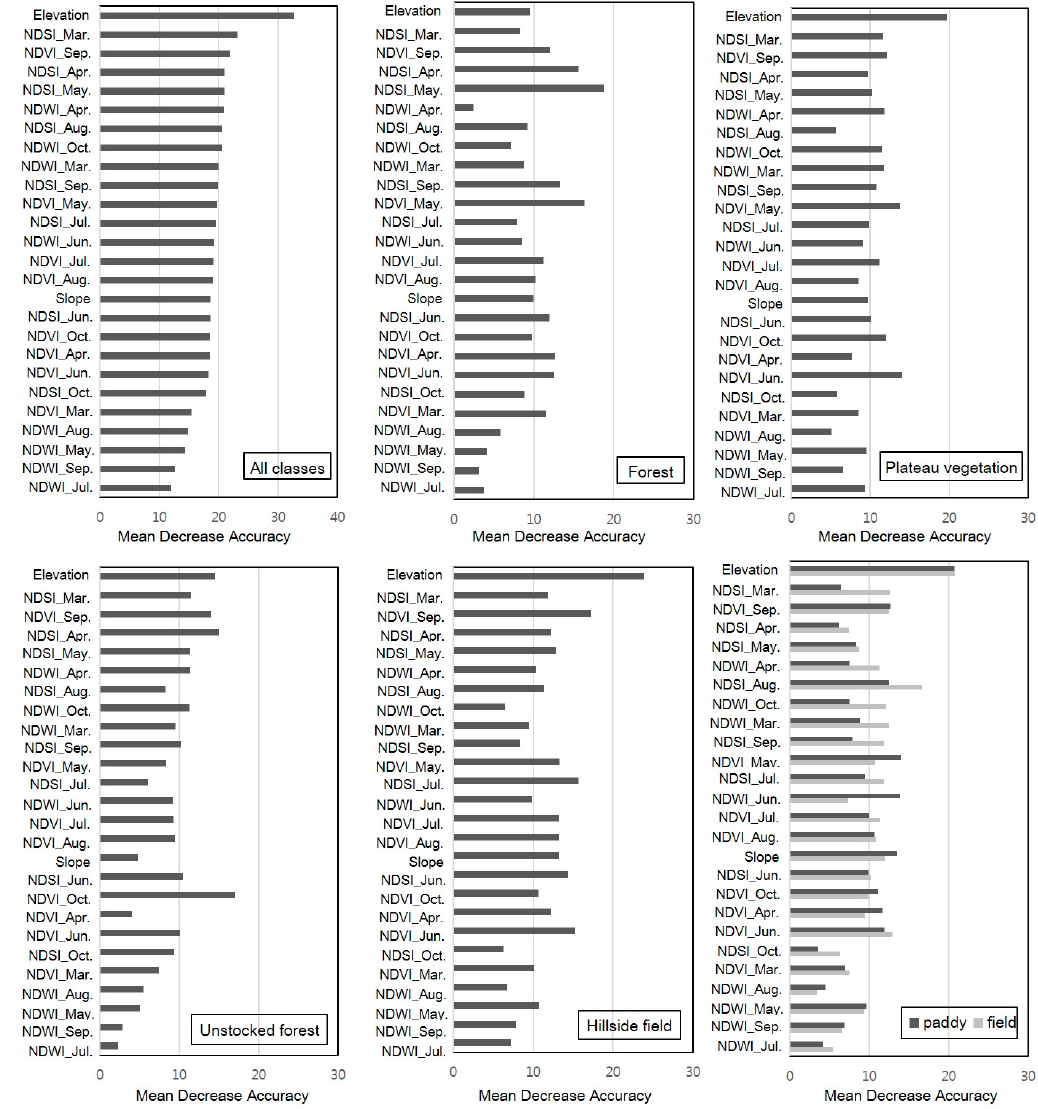
Figure 5. Mean decrease accuracy values of overall and for each class from the RF classification using phenology-based multi-index and topographic variables.